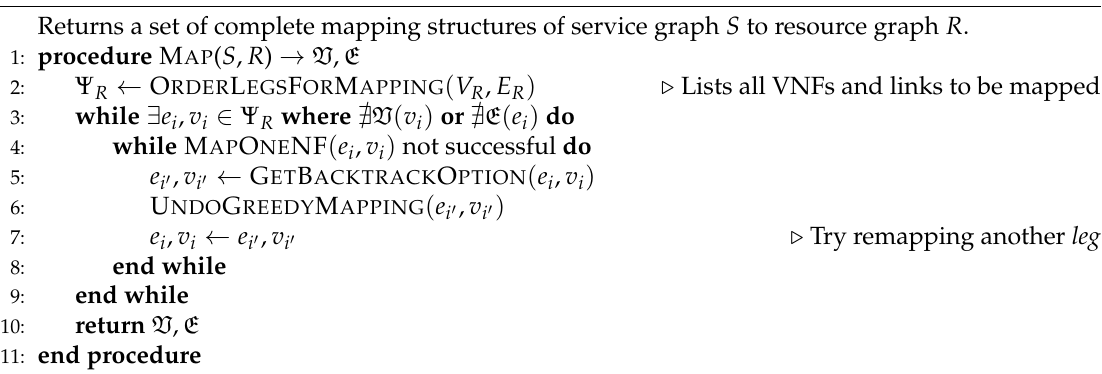
Algorithm 1 Overview of the Greedy Backtrack Metaheuristic for VNE Returns a set of complete mapping structures of service graph S to resource graph R .